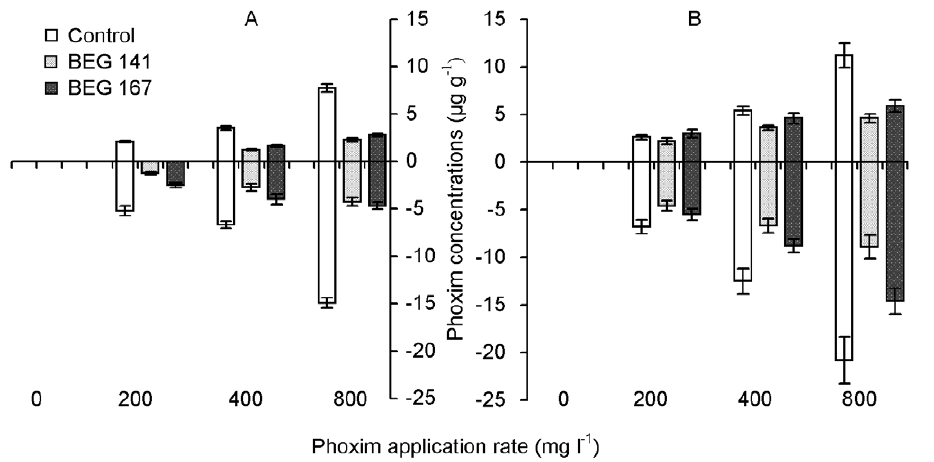
Figure 3. Shoot (above X-axis) and root (below X-axis) phoxim concentrations (means ± SE, n =3) of carrot (A) and green onion (B). Control, BEG 141 and BEG 167: non-AM-inoculation control, G. intraradices BEG 141 and G. mosseae BEG 167, respectively.